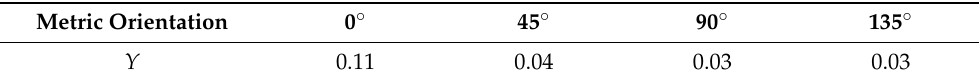
Table 7. CV values for the maximum Y values at every